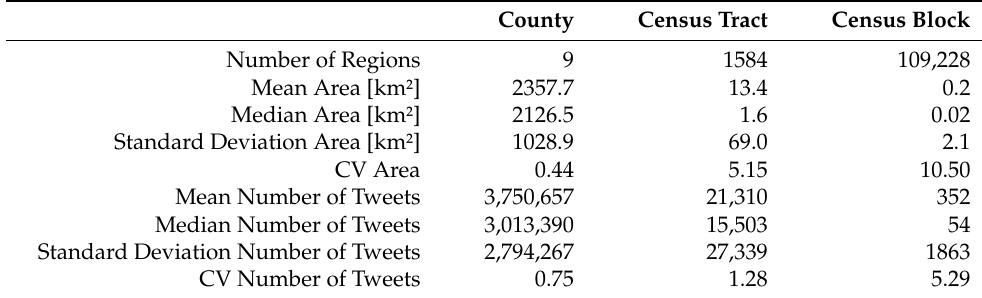
Table 1. Study area